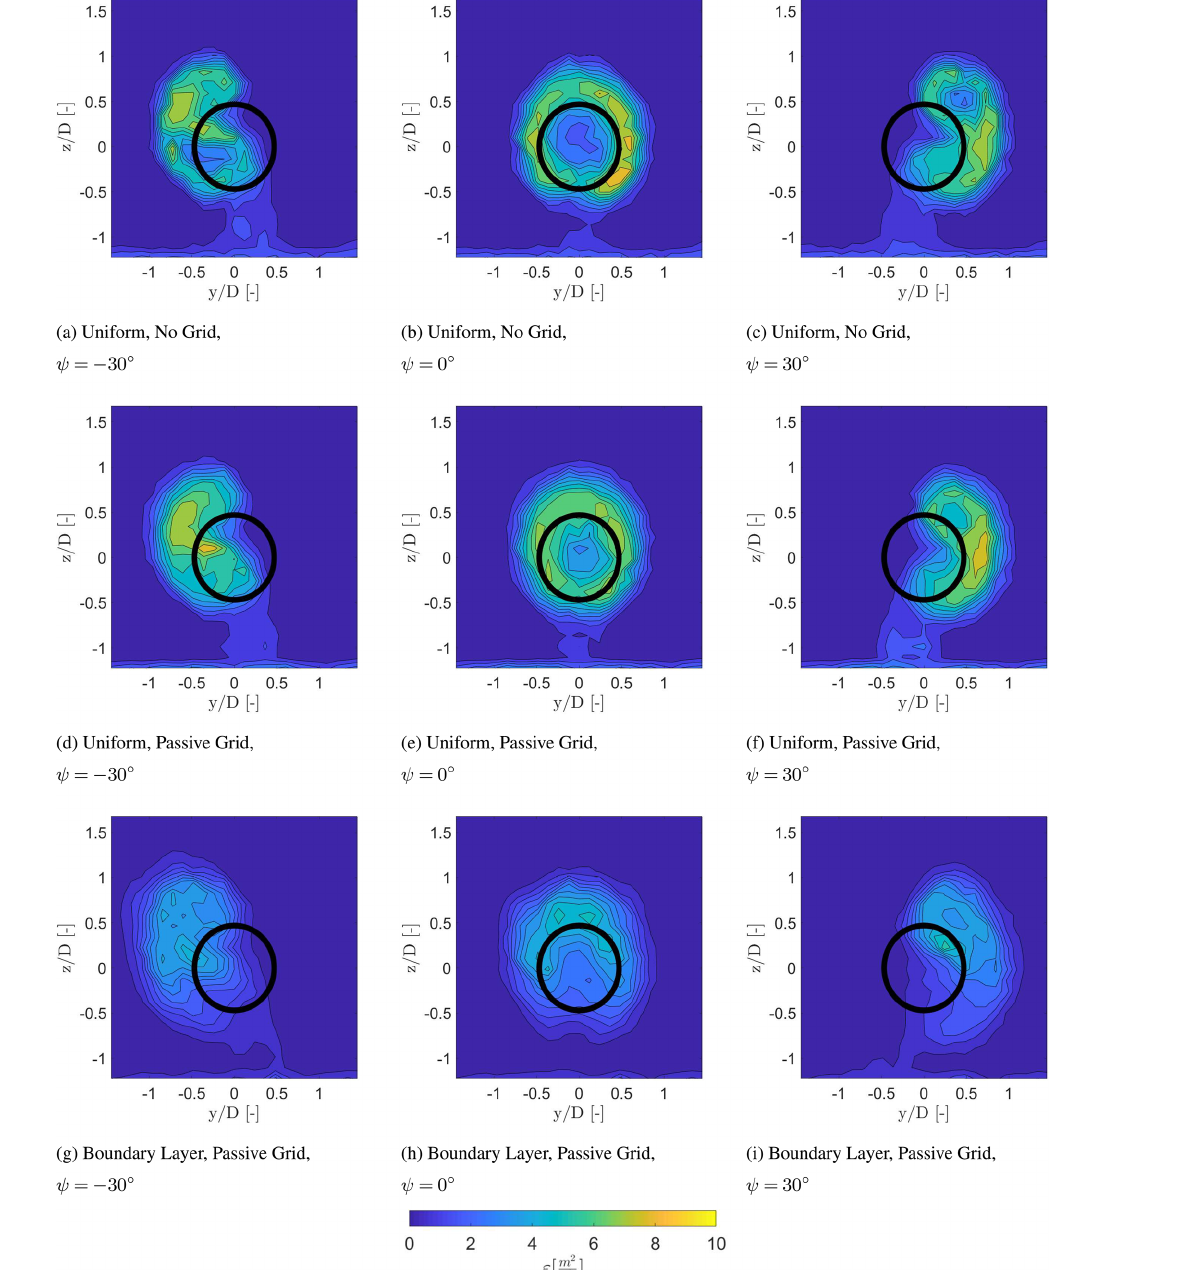
Figure 8. Energy dissipation rate within the wake at a downstream distance of 5 D for different inflow conditions. The wake is viewed looking upstream towards the turbine